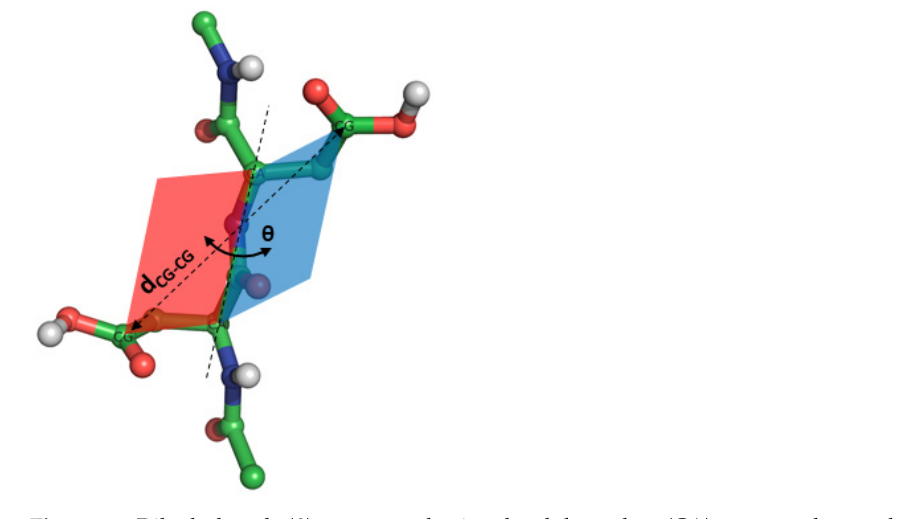
Figure 11. Dihedral angle ( θ ) constructed using the alpha carbon (CA) atoms and two selected atoms located in the side chain. In this case, carboxyl carbon (CG) atoms are selected. Table S3 indicates the atom selection for each amino acid.